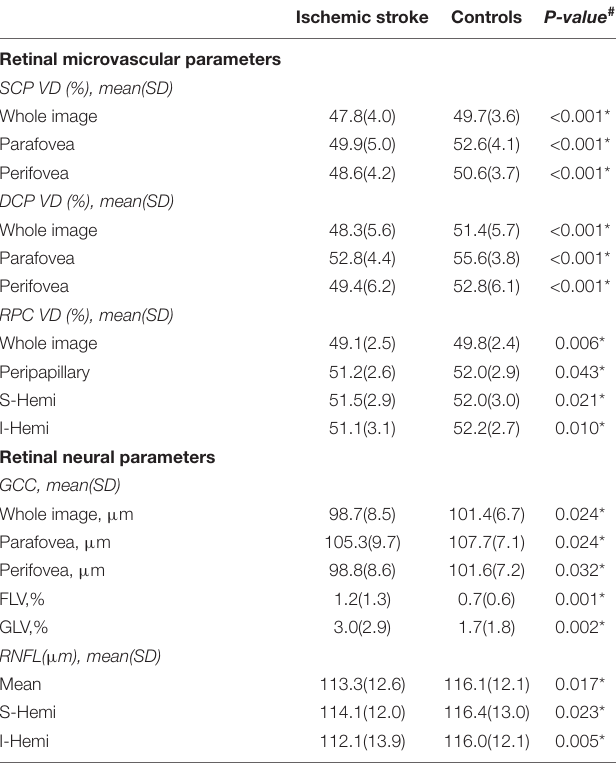
TABLE 2 | Comparison of optical coherence tomography angiography (OCTA) parameters in the two groups. Ischemic stroke Controls P-value